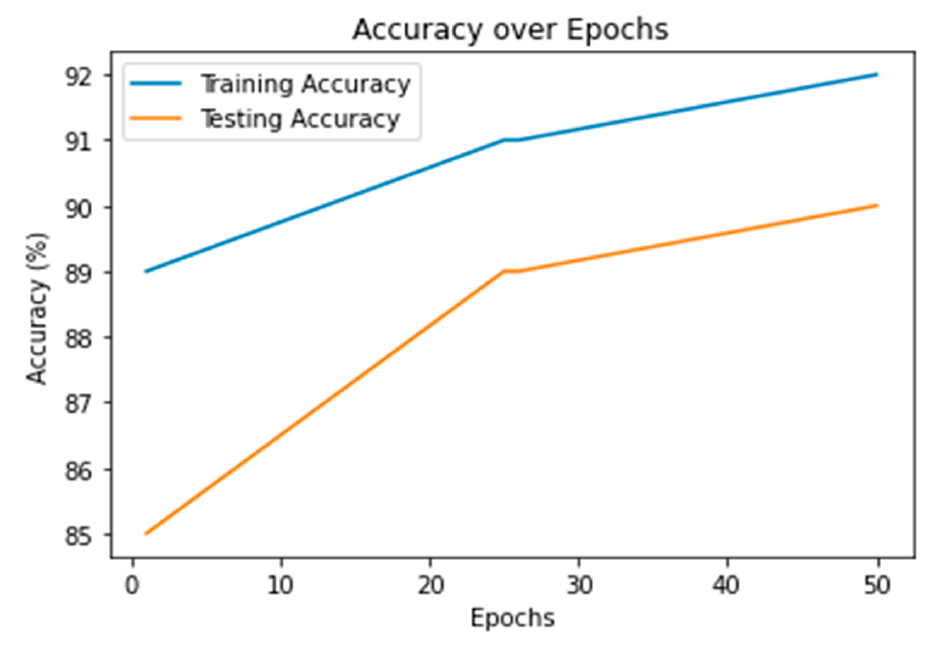
Figure 13. Training and testing accuracies of simple 3D U-Net classifier.